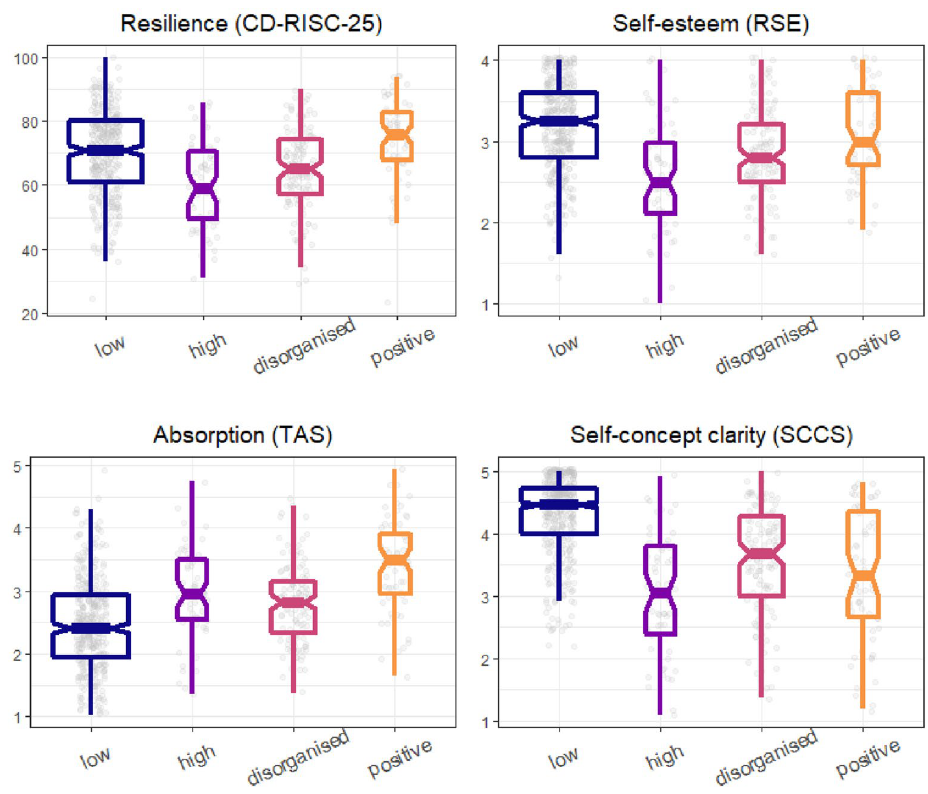
Figure 2. Comparison of the schizotypy clusters. See Table 2 for the results of the statistical analyses. Note that the points are jittered to facilitate